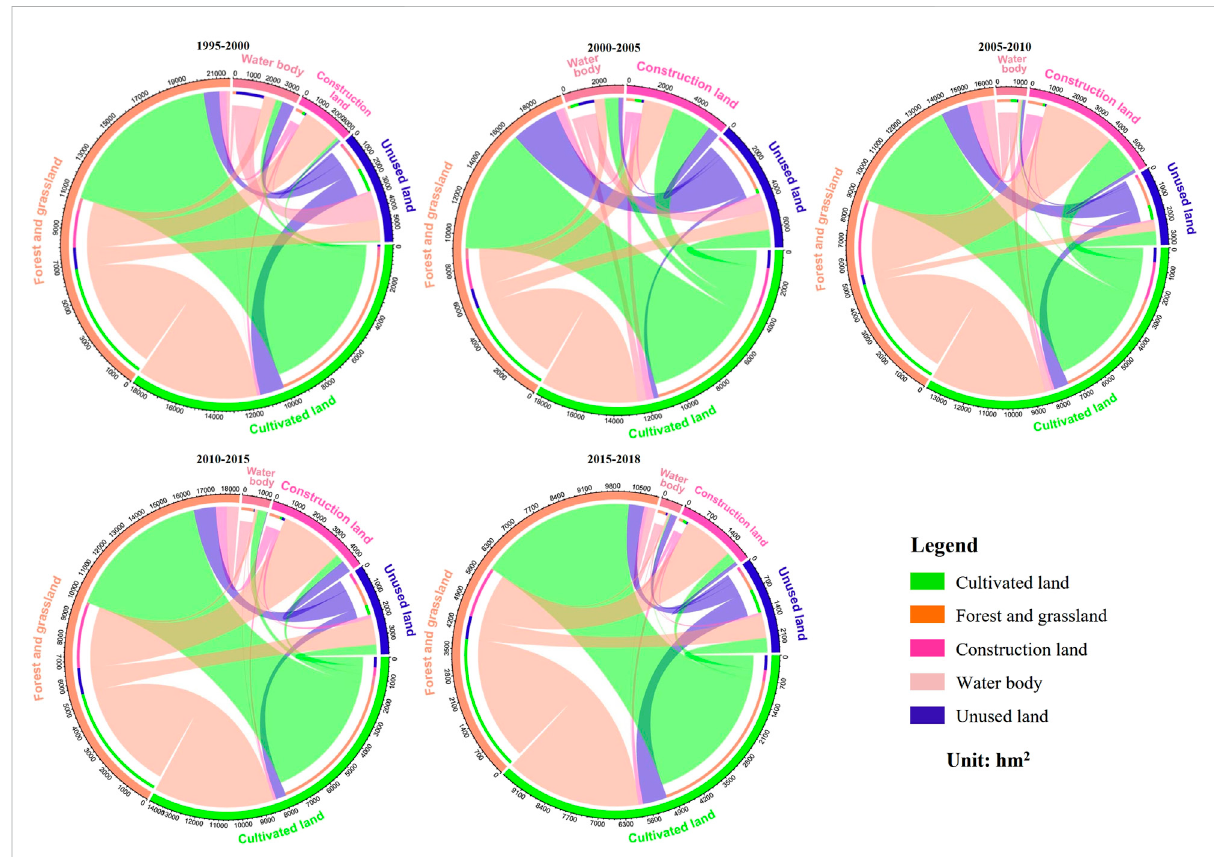
FIGURE 4 Land use types transfer in the mountainous area of Yuxi City from 1995 to